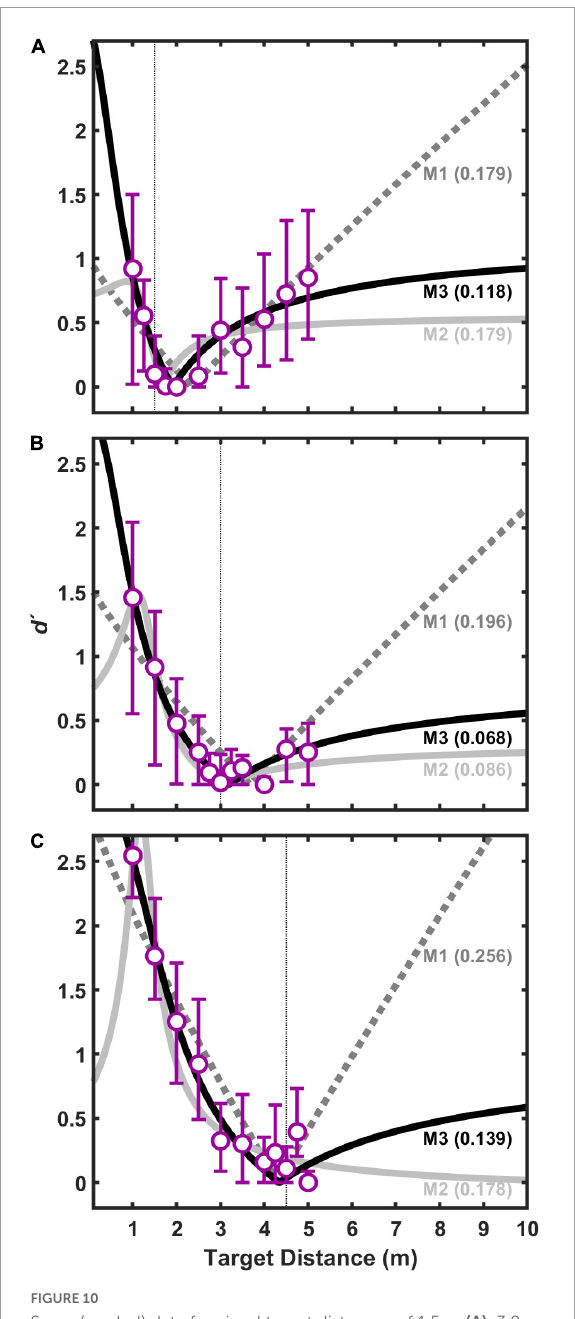
FIGURE10 Same (pooled) data for visual target distances of 1.5 m (A) , 3.0 m (B) , and 4.5 m (C) as shown in Figure 5 , but fits displayed are for 3-parameter ( k aud , r, σ aud )